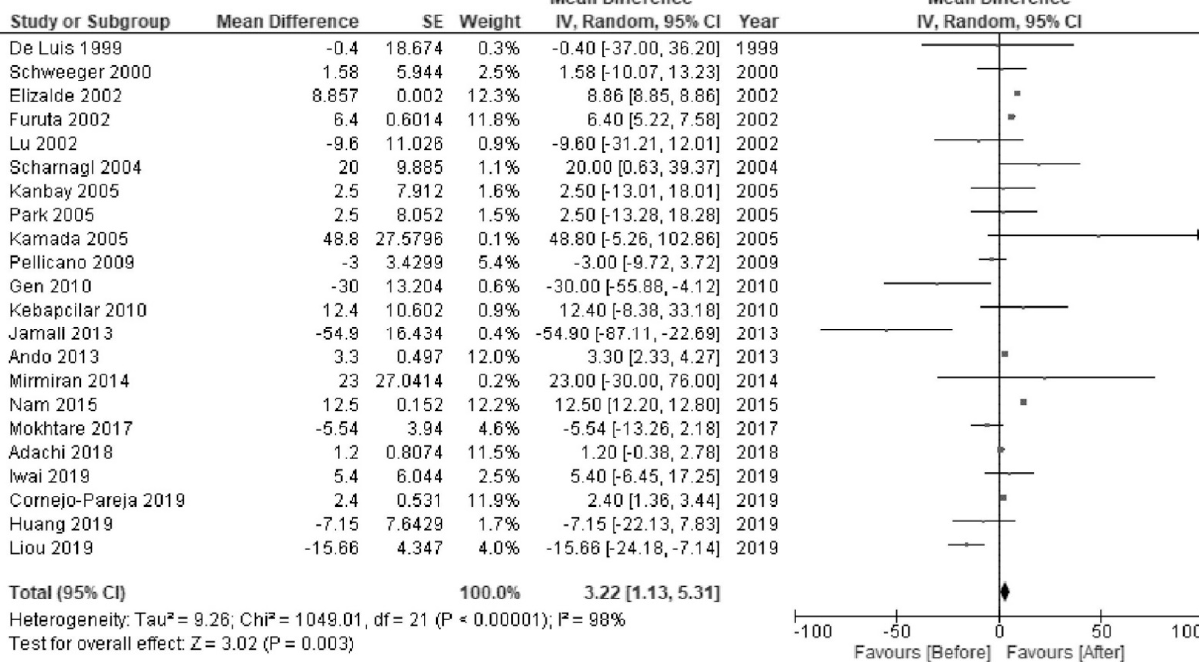
J. Clin. Med. 2021 , 10 , 904 Figure 3. Forest plot of the mean changes in triglyceride levels before and after Helicobacter pylori eradication.